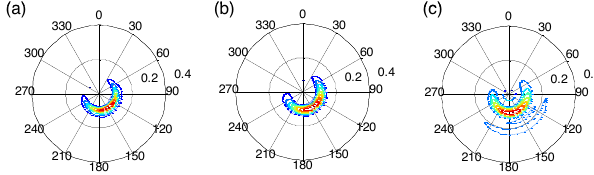
Fig. 3. Directional wave spectra at the Hualien buoy on 26 July 2006 at 0500 UTC: (a)